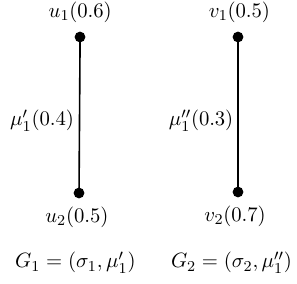
Figure 5. Not strong fuzzy-graph Figure 5: Not Strong Fuzzy Graph Structures